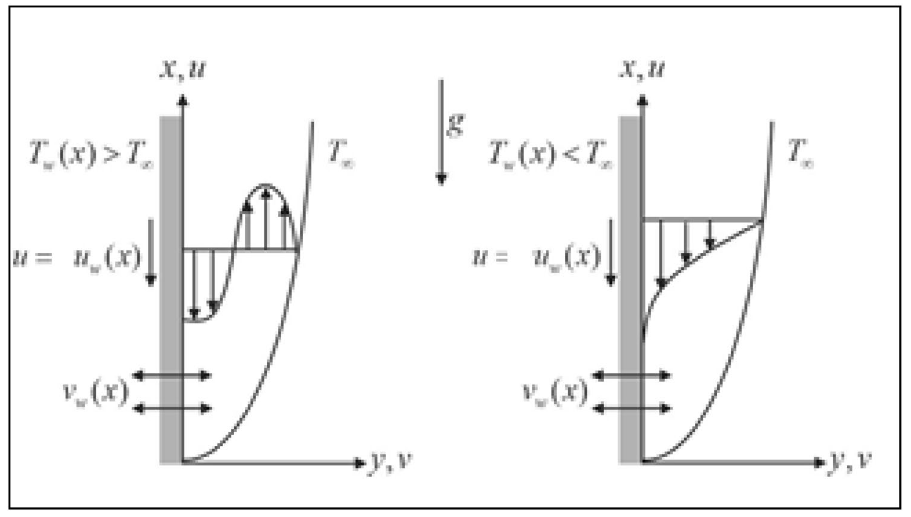
Figure 1. Physical model of the